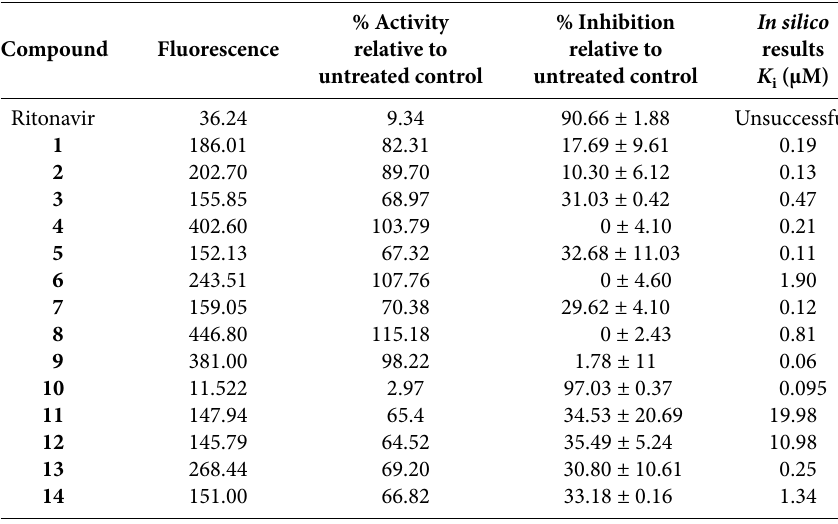
Table 5. HIV-1 protease screening results of the screened 1 – 14 diamine derivatives of benzoyl isothio- cyanate. % Activity % Inhibition In silico Compound Fluorescence relative to